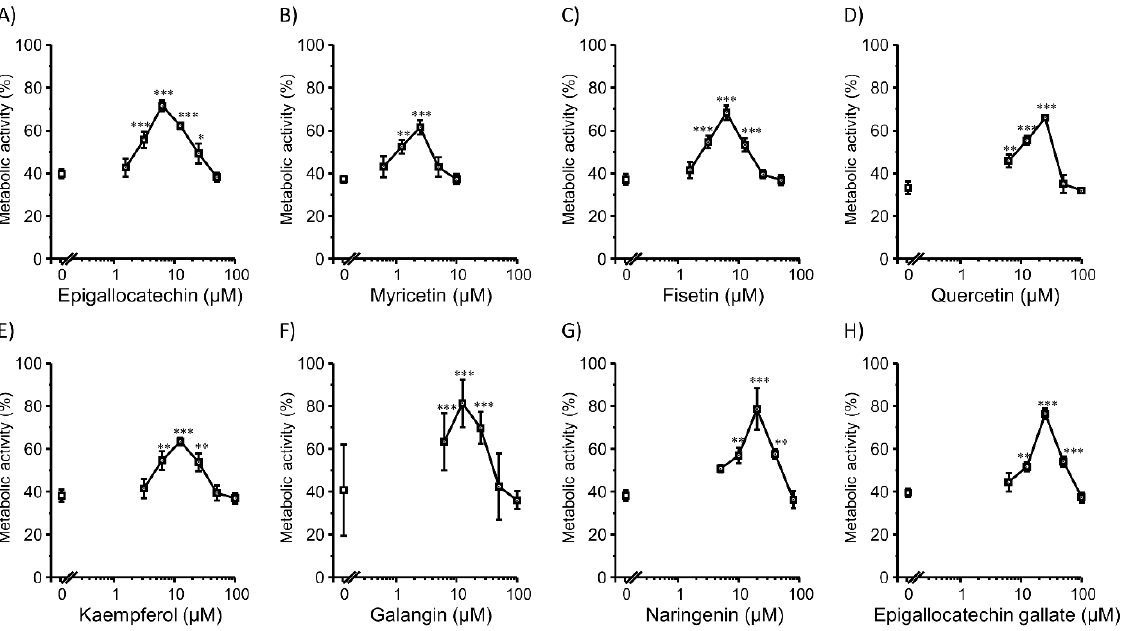
Figure 2. Metabolic activity of cells co-incubated with flavonoids and Lipofectamine 3000/plasmid DNA (pcDNA3/GL 0.2 µg/well) complexes in 2D Colon26 cells. ( A ) Epigallocatechin (0–50 µM). ( B ) Myricetin (0–10 µM). ( C ) Fisetin (0–50 µM). ( D ) Quercetin (0–100 µM). ( E ) Kaempferol (0–100 µM). ( F ) Galangin (0–100 µM). ( G ) Naringenin (0–80 µM). ( H ) Epigallocatechin gallate (0–100 µM). Each dot represents the mean ± SD ( n = 3). * p < 0.05, ** p < 0.01, *** p < 0.001 compared with the control (0 µM flavonoids).